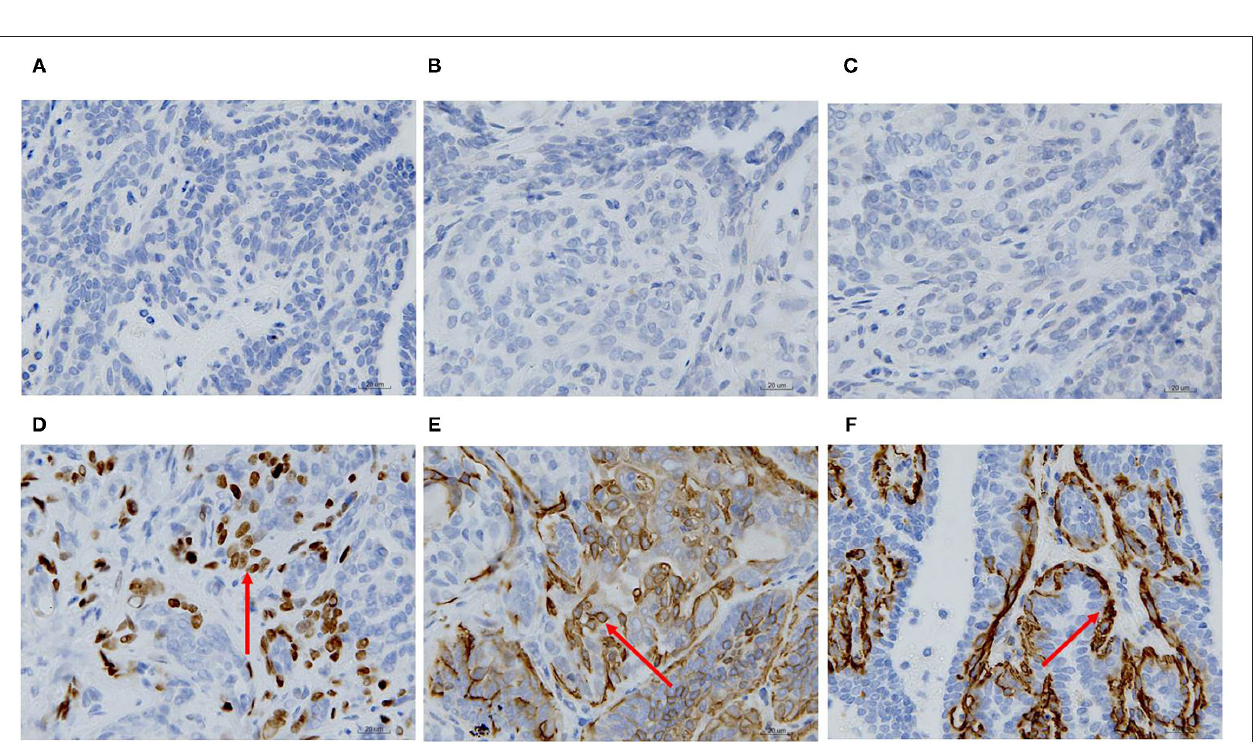
FIGURE 2 | Immunohistochemical staining of the primary carcinoma sections (400X). The dark brown color was observed as positive staining. Tissues from the primary cancer were negative for ER (A) , PR (B) and HER-2 (C) , and were positive for P63 (D) , CK5/6 (E) , and α -SMA (F) localized in the cell membrane.